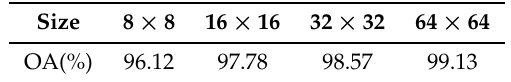
Table 6. OA of Bi-CLSTM with different sizes of input image patches on the KSC dataset.